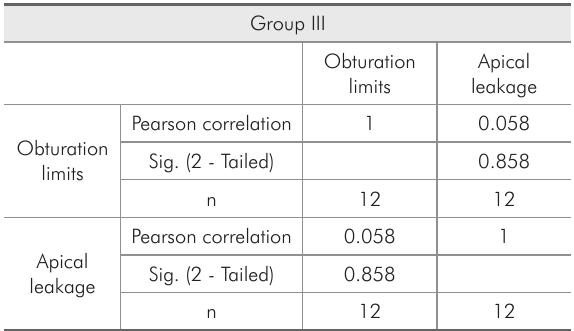
Table 3 - Correlation analysis of Group III.